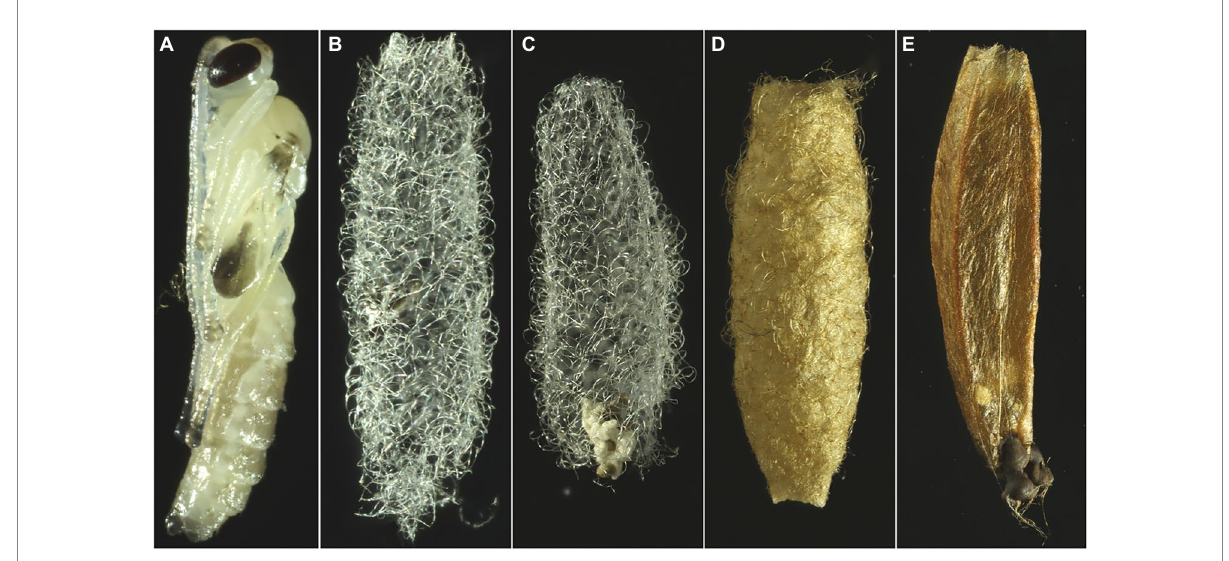
FIGURE 1 Tested bare pupa of Zatypota percontatoria (A) as control and the two tested cocoon types. Cocoons with a soft wall produced by Z. percontatoria (B) and Zatypota anomala (C) , and cocoons with a strong wall produced by Zatypota albicoxa (D) and Acrodactyla carinator (E)